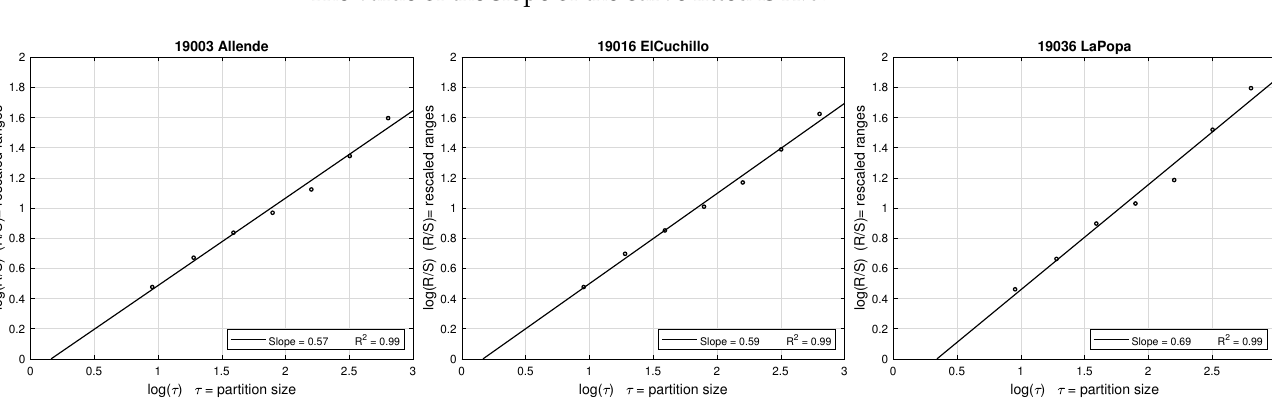
Figure 2. Time series of the stations Allende, El Cuchillo and La Popa. Figure 3 shows the linear adjustments applied to Equation (7) for the selected stations. The calculation of the Hurst exponents was made by means of the least squares method. The value of the slope of the curve fitted is Hrs .